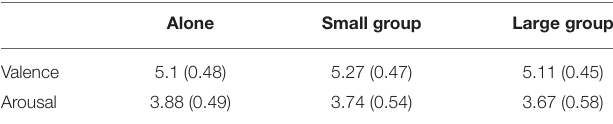
TABLE 2 | Normative values of mean (SD) valence and arousal for the images included, as reported in the OASIS database.